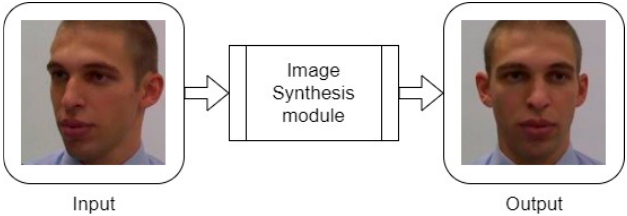
Figure 4. Input and output of the Image Synthesis module (intended function, not the result of a real experiment).